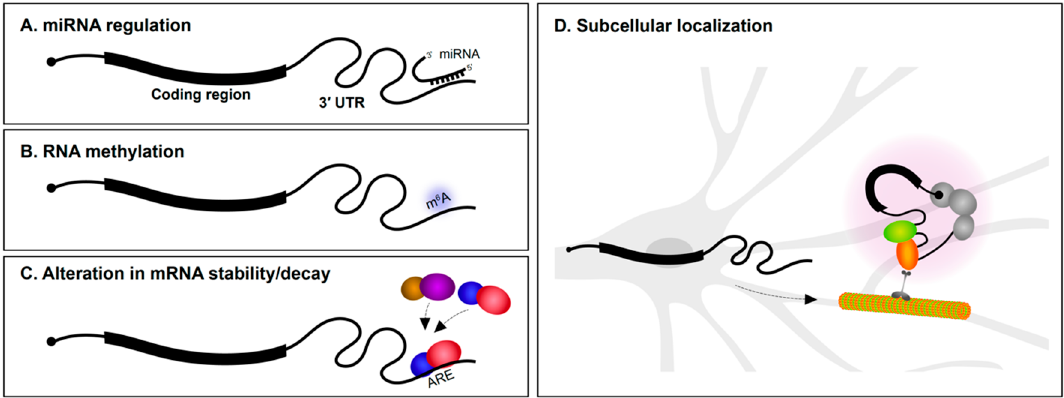
Figure 1. Post-transcriptional regulation via 3 ′ untranslated regions (3 ′ UTRs). 3 ′ UTRs mediate post-transcriptional gene regulation via ( A ) miRNA interactions, ( B ) RNA methylation, ( C ) regulating mRNA stability/decay by interaction with RNA-binding proteins (RBPs; illustrated as colored balls), and ( D ) imparting subcellular localization within neurons to regions such as dendrites and axons, where they can undergo local translation. ARE, AU-rich element.